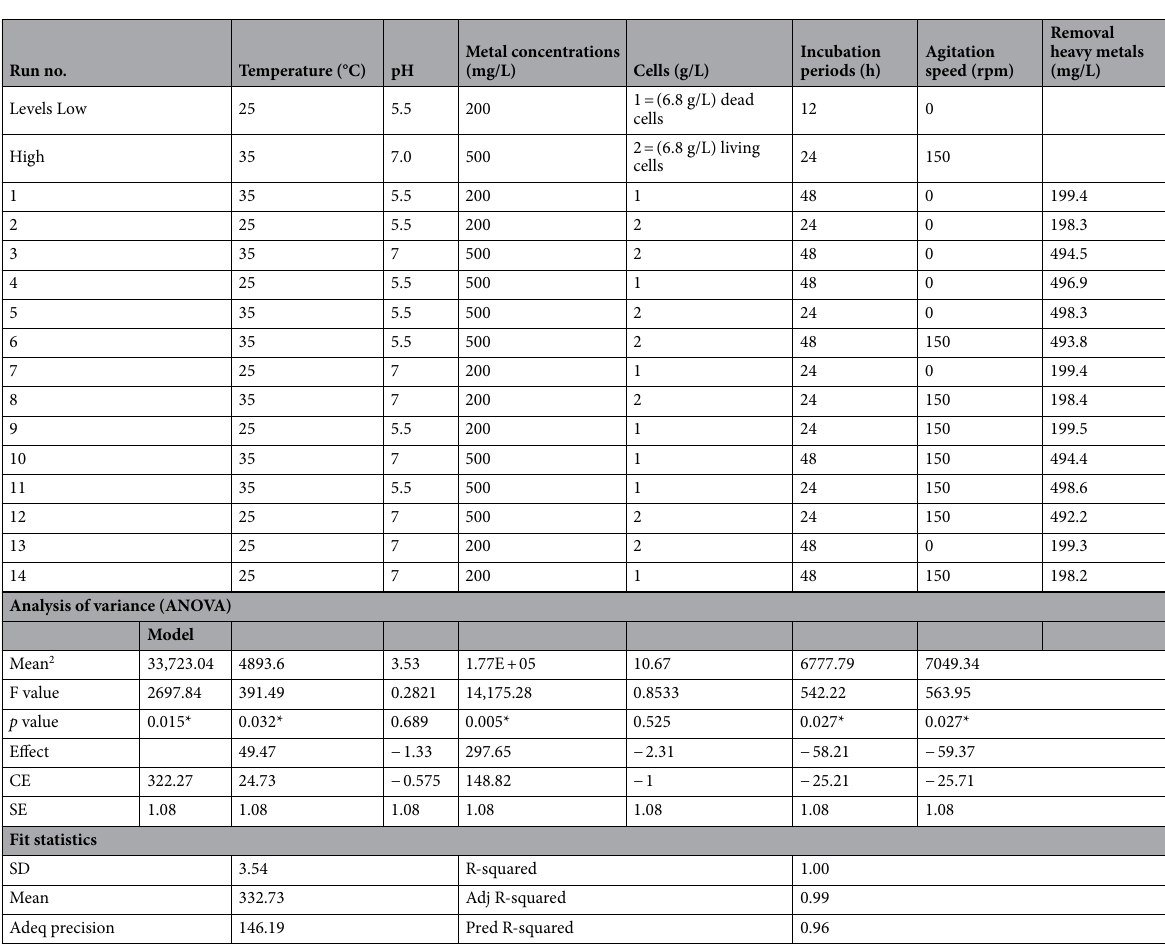
Table 3. Minimum Run Resolution IV experimental design matrix, the results of actual values, analysis of variance (ANOVA), and fit statistics of variables affecting Pb 2+ metal removal by 17OS strain. Mean 2 Mean Square, P Corresponding level of significance, F Corresponding level of significance, CE Coefficient estimate, SE Standard error, SD Standard deviation, R 2 Determination coefficient, Adj . Adjusted, Pred . Predicted, Adeq . Adequate. *Significant at 5% level ( p <